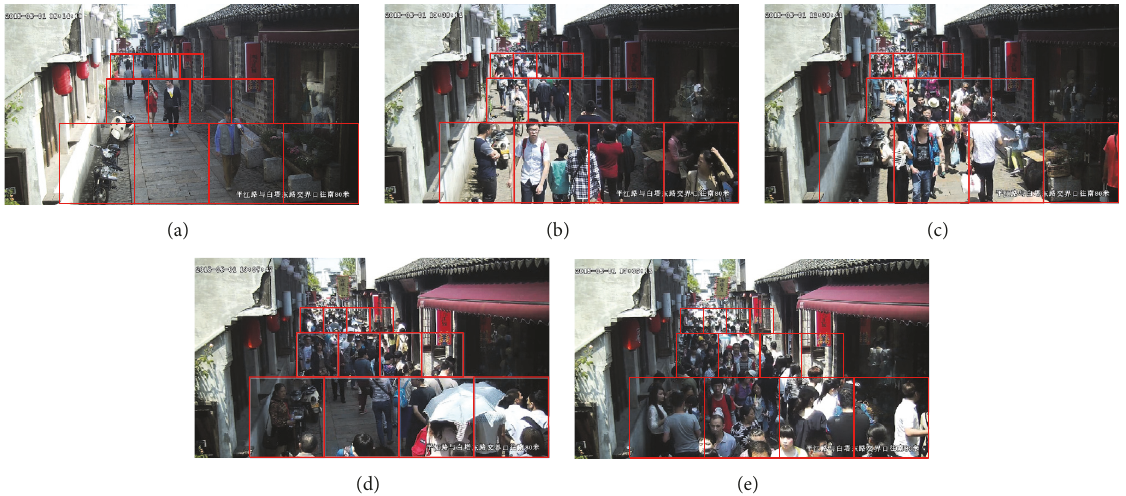
Figure 9: The different density images on scene 1: (a) very low, (b) low, (c) medium, (d) high, and (e) very high.